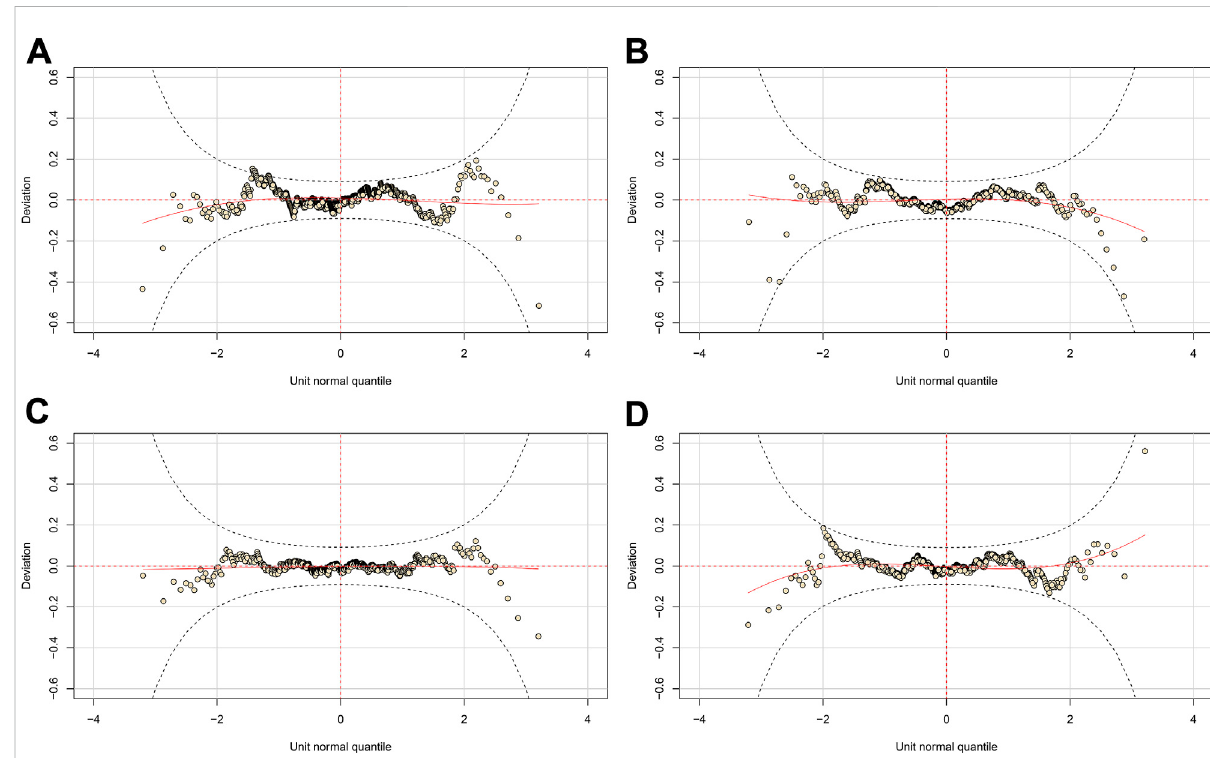
FIGURE 1 Worm plots of fi tted GAMLSS model. (A) Sit and reach test; (B) t test; (C) 30 m run test; (D) vertical jump test.